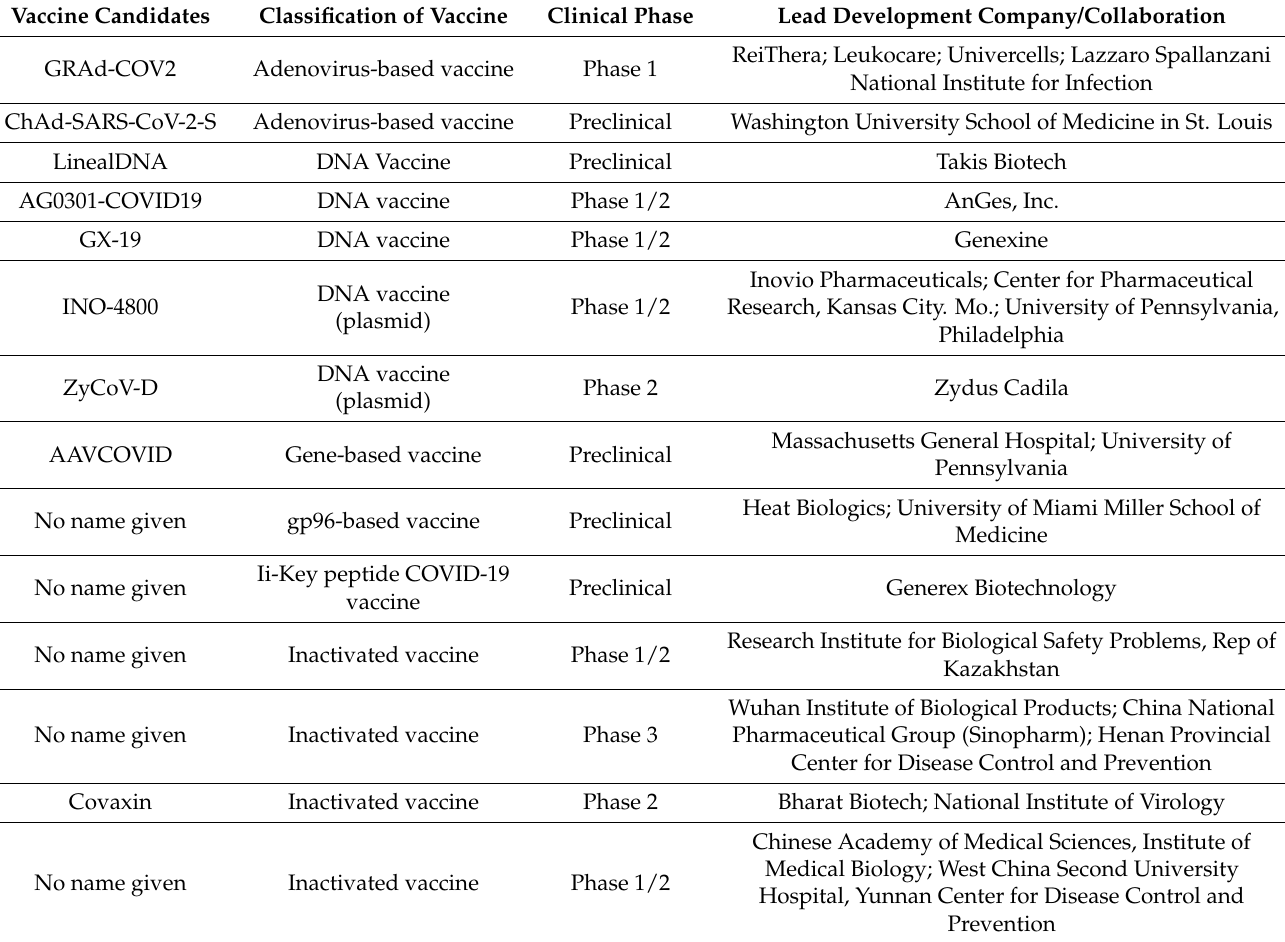
Table 1. List of some of the current marketed and investigational vaccine candidates for SARS-CoV-2. Vaccine